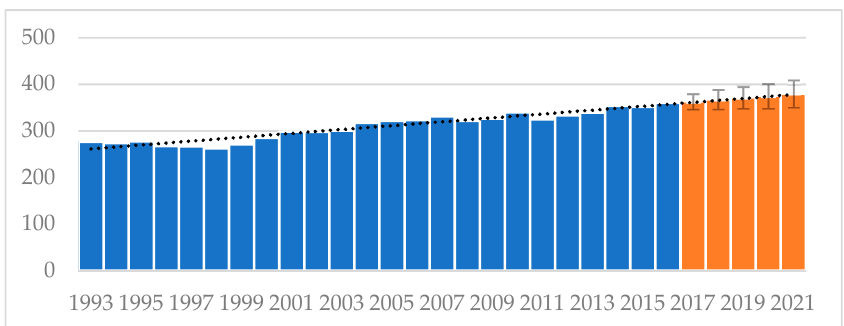
Figure 3. The trend for the number of people employed in the Health and Social Care sector in the Czech Republic (in thousands of people) 1993–2016, with a prediction 2017–2021.